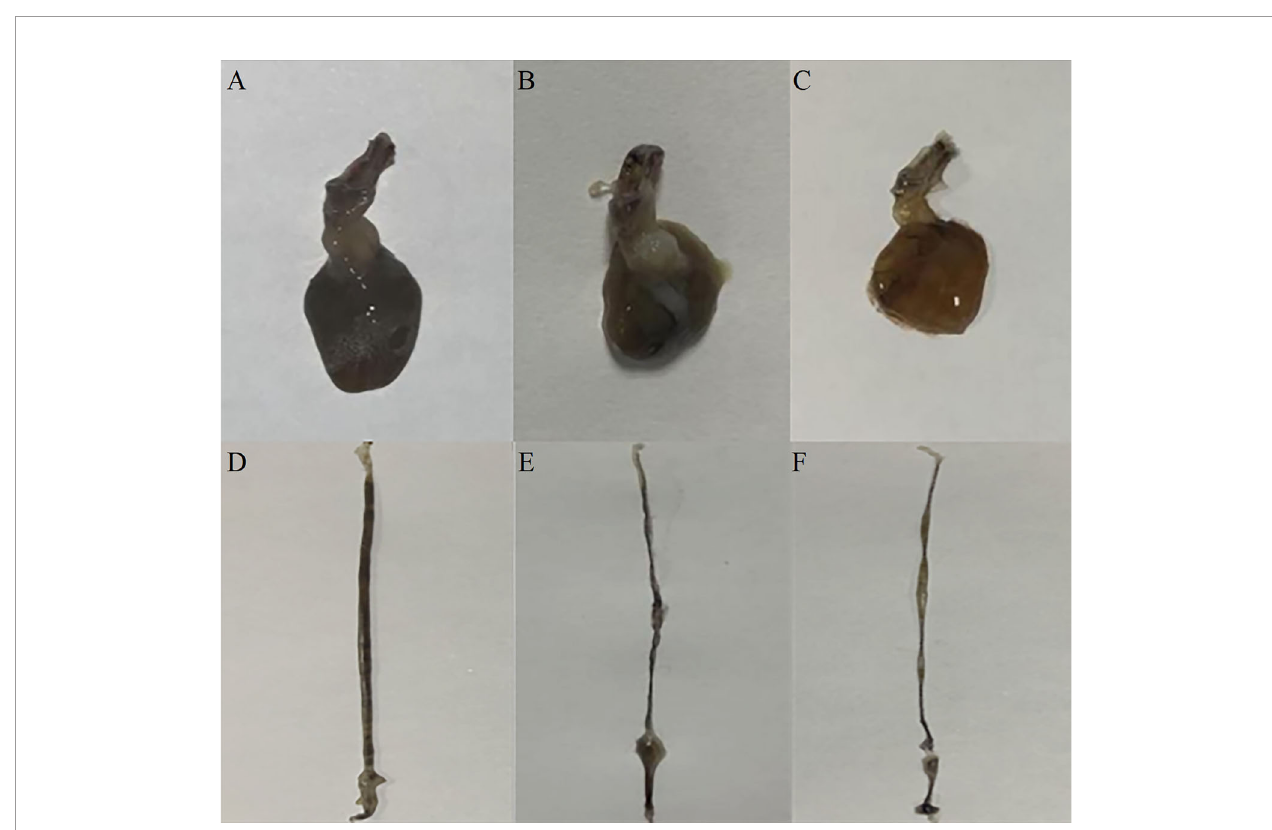
FIGURE 7 | The effect of silencing LvFABP expression by dsLvFABP interference on hepatopancreas and intestine morphology of L. vannamei challenged with the VP AHPND strain VP-E1. (A, D) : hepatopancreas and intestine morphology of L. vannamei after dsLvFABP-injected shrimp were challenged with the AHPND-causing V. parahaemolyticus VP-E1 strain; (B, E) : hepatopancreas and intestine morphology of L. vannamei after NaCl-injected shrimp were challenged with the AHPND- causing V. parahaemolyticus VP-E1 strain; (C, F) : hepatopancreas and intestine morphology of L. vannamei after dsEGFP-injected shrimp were challenged with the AHPND-causing V. parahaemolyticus VP-E1 strain.